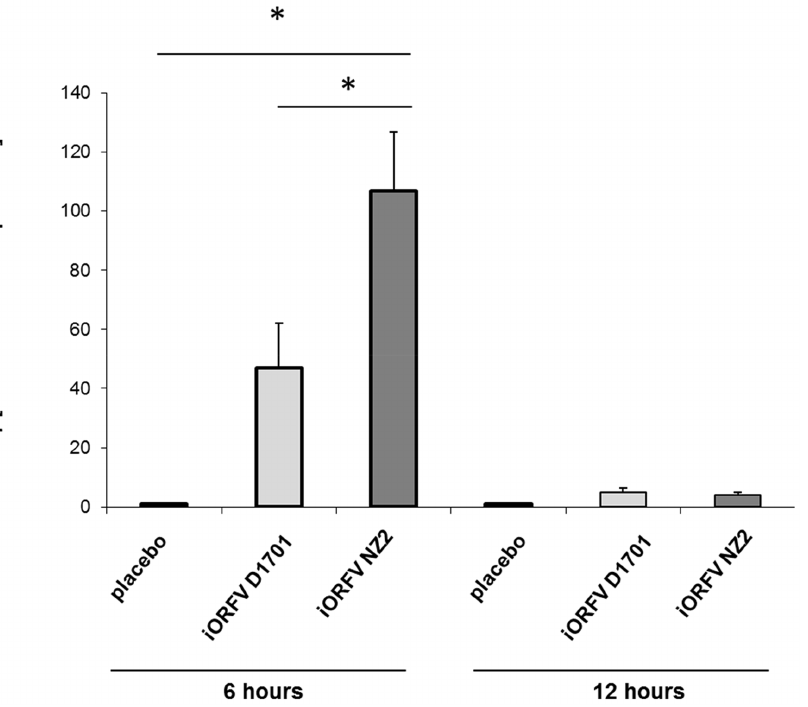
Figure 3. iORFV strain NZ2 is a more potent inducer of IFN- c as compared to strain D1701. BALB/c mice (n=6/group) were treated i. p. with iORFV at a dose of 5 6 10 4 TCID 50 of either strain of iORFV. PBS-inoculated animals served as control. Peritoneal lavage cells were collected 6 or 12 h after iORFV administration and analyzed for IFN- c expression using a quantitative RT-PCR. Values shown are means 6 standard error of means (SEM). Statistical analyses were performed using the one-way ANOVA and as post hoc analysis the Newman-Keuls Multiple Comparison Test. *p , 0.05, ***p , 0.001. doi:10.1371/journal.pone.0074605.g003 PLOS ONE |